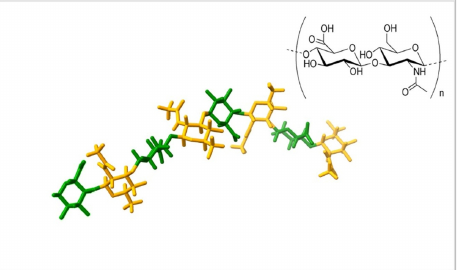
Figure 1. The structure of the hyaluronic acid. The polymer consists of α -D-glucopyranuronic acid (green) and 2-acetamido-2-deoxy- β -D-glucopyranose (orange) linked by glycosidic bonds. The pol- ymer can reach extremely large volumes by gathering molecules of water. Source: Protein Data Bank [16]. Structural formula reprinted from Reference [17], based on CC BY license. Illustration created using UCSF ChimeraX (version 1.2.5.), developed by the Re- source for Biocomputing, Visualization, and Informatics at the University of California, San Francisco, with support from National Institutes of Health R01-GM129325 and the Office of Cyber Infrastructure and Computational Biology, National Institute of Allergy and Infectious Diseases [18]. This review gives an overview of the current state of art in the field of the composites of silver nanoparticles and biopolymers based on hyaluronic acid. It presents the methods of synthesis of such composites, their physicochemical and biological properties, and dis- cusses medical implementation of these materials.